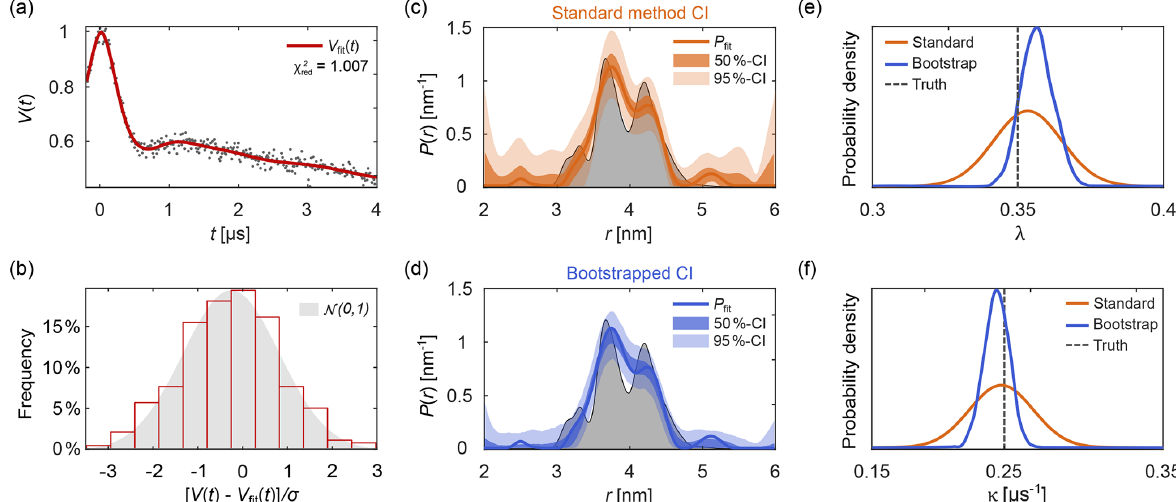
Figure 10. Uncertainty analysis. In panel (a) a simulated noisy four-pulse DEER signal with exponential background (grey dots) is fitted with a non-parametric distance distribution (red line). In panel (b) , the red bars show the histogram of normalized residual values and the reference standard Gaussian distribution as a grey shaded area. In panels (c) and (d) the fitted distance distribution is given as blue/orange lines as well as the 50% and 95% confidence intervals (shaded areas) obtained via the standard method (orange, top) and via bootstrapping (blue, bottom). The ground truth distribution is shown as a shaded grey area for reference. The estimated distribution of the fitted modulation depth λ (e) and background decay rate constant κ (f) obtained via the standard method are given as orange lines. The kernel density estimations obtained via bootstrapping are given as blue lines. The true values of λ and κ are given as a dashed grey line for reference. All bootstrap results were obtained from 1000 bootstrap samples and the regularization parameter was optimized using AIC for the original signal and fixed throughout the